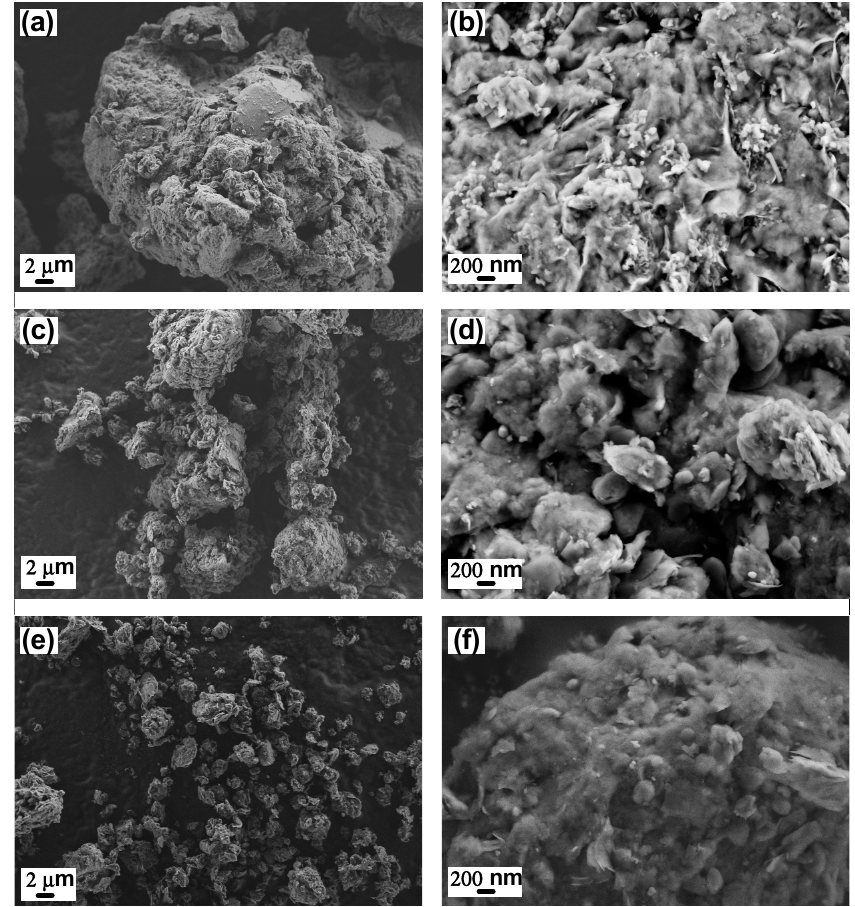
Figure 5. SEM images of ( a , b ) BT, ( c , d ) PB, and ( e , f ) RM adsorbent.